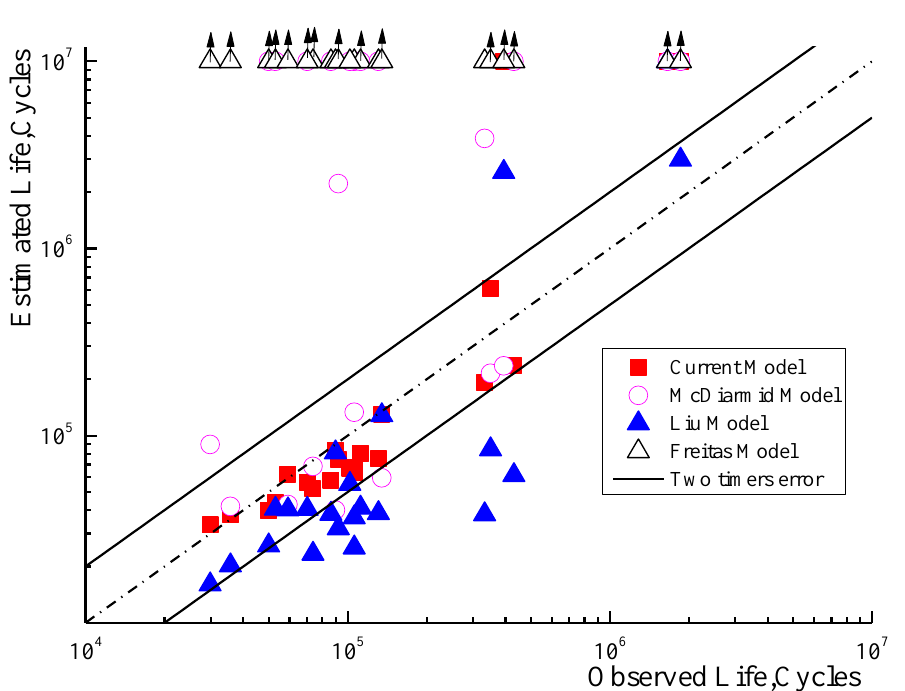
Figure 7. Experimental and predicted results for aluminum alloy LY12CZ.